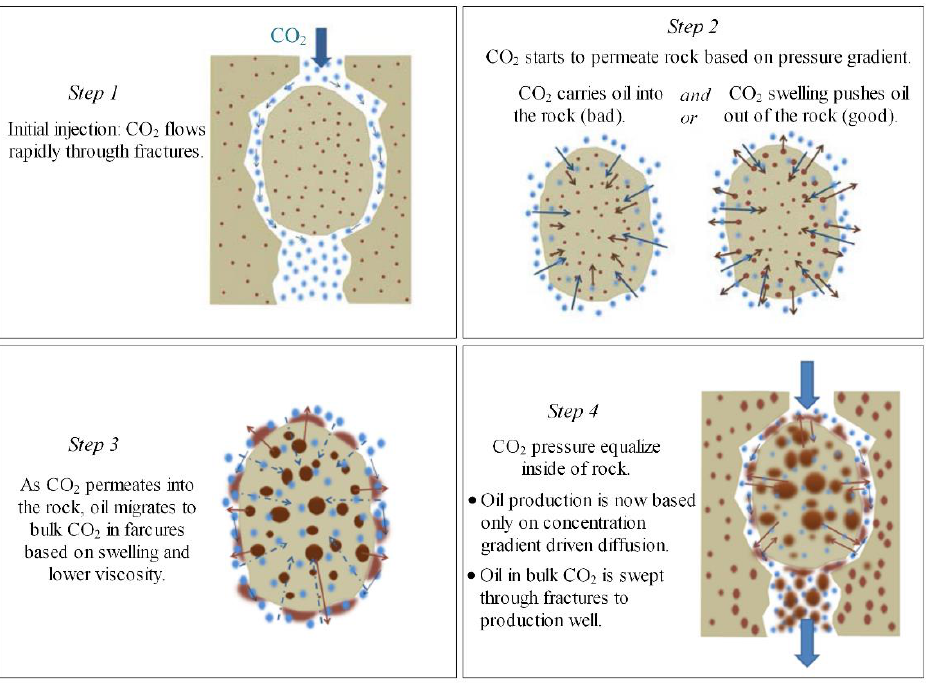
Figure 14. Conceptual steps of CO 2 -enhanced oil recovery (CO 2 -EOR) in fractured tight oil reservoirs ([201]).